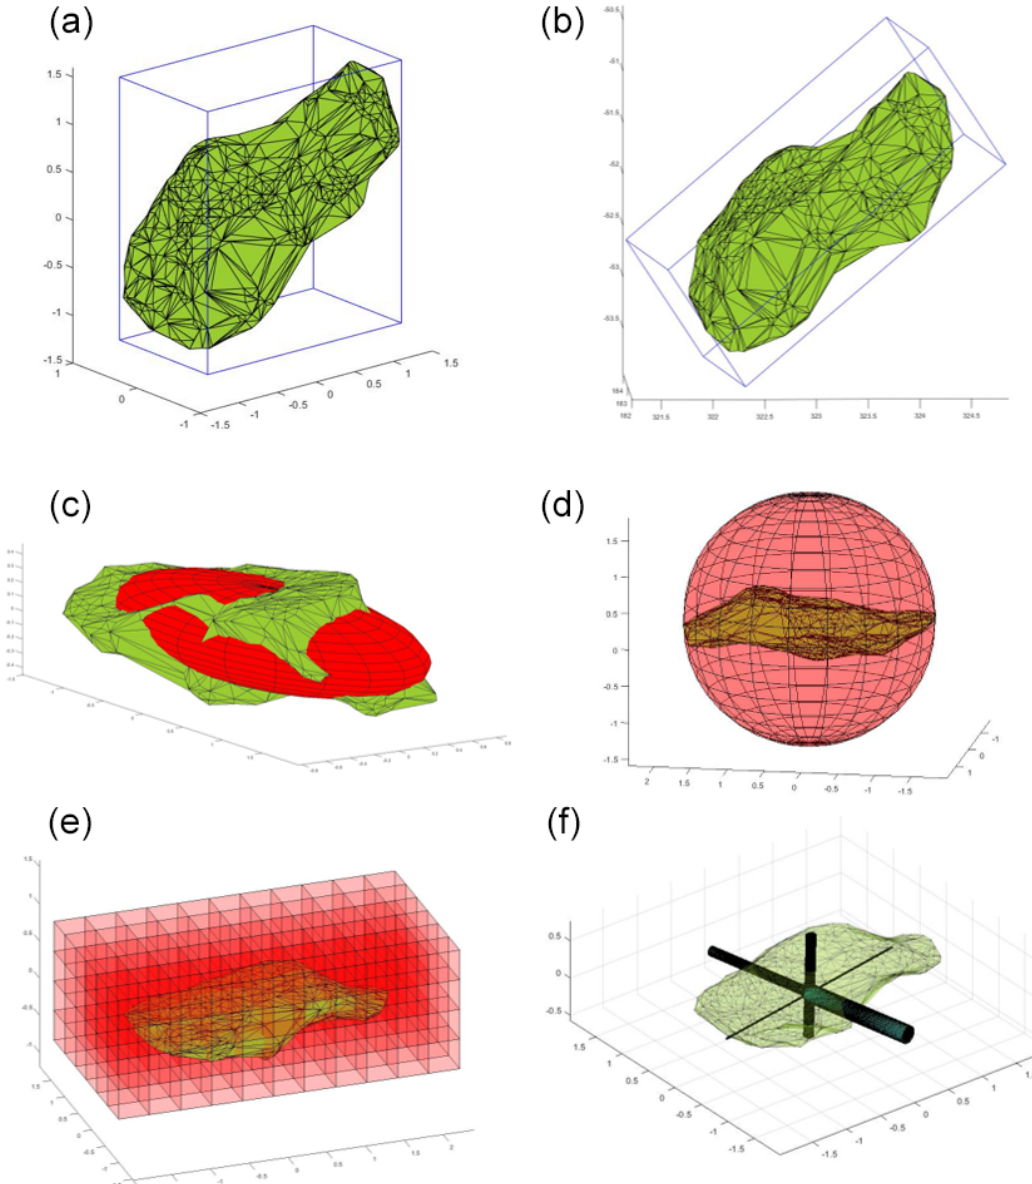
Figure 6. Visual representation of each of the model fitting methods used in the study. (a) Bounding box approach (e.g. van Veen et al., 2017; Benjamin, 2018; Williams, 2017). (b) Adjusted bounding box approach. (c) Least-squares ellipsoid fit. (d) Minimum bounding sphere fit. (e) RFSHAPZ approach. (f) RFCYLIN